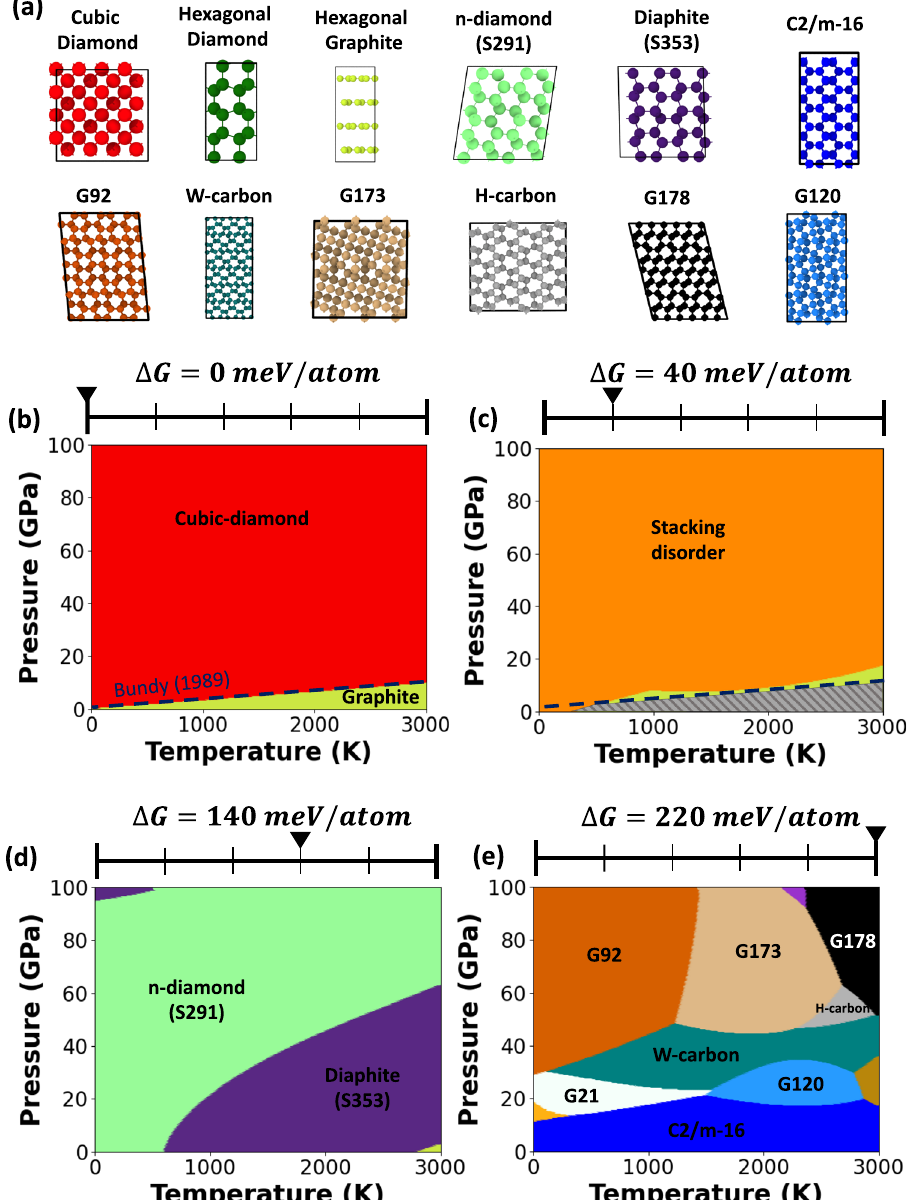
Fig. 2 Machine learning a metastable phase diagram for carbon. a Phases that appear within Δ G (cid:5) 220 meV/atom. b Equilibrium phase diagram with boundary fi tted using MSVM. Equilibrium phase diagrams matches the experimental phase diagram 19,48 . c – e Metastable phase diagram (at a Δ G of 40, 140, and 220 meV/atom respectively) showing metastability of phases listed above. The color on the phase diagrams corresponds to the color of the structures shown in ( a ). Regions where no metastable phase is present other than the ground state are shaded in